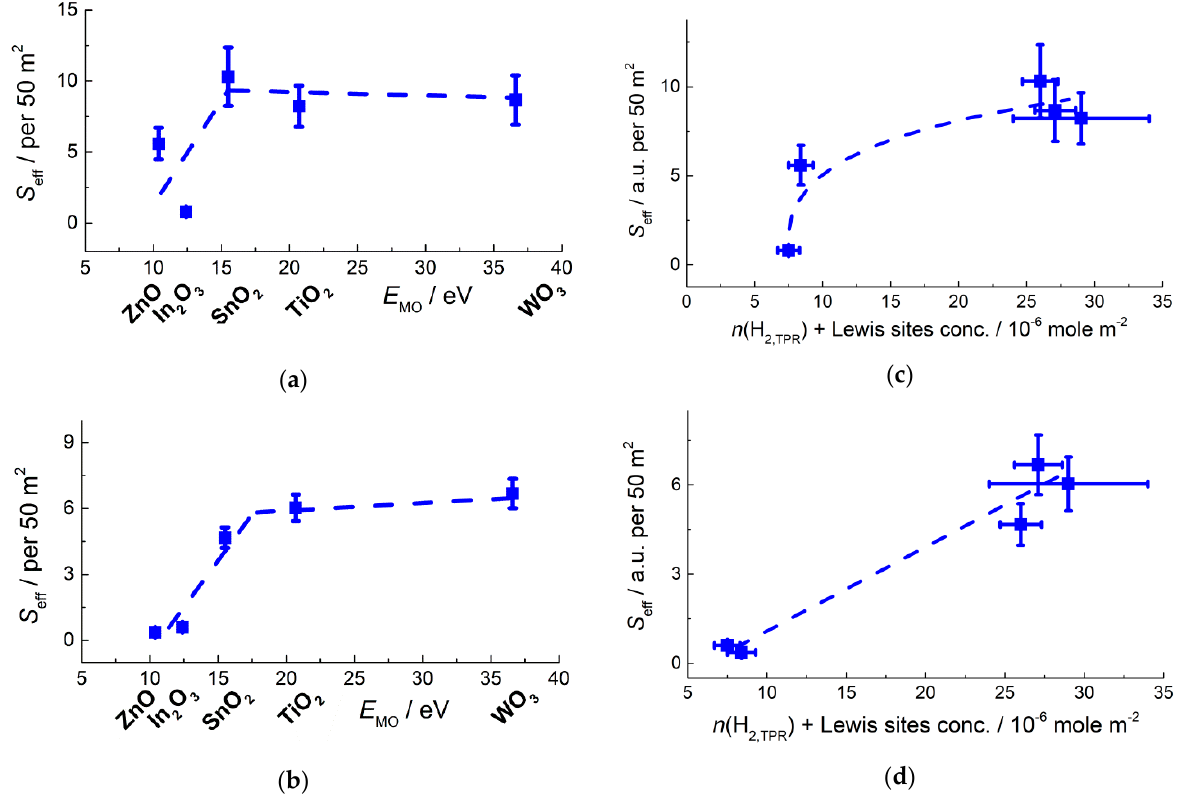
Figure 19. Sensitivity of pristine and Au-functionalized nanocrystalline n -type MOS to 20 ppm acetone ( a , c ) and 20 ppm methanol ( b , d ) at temperature 300 °C in relation to metal-oxygen bond energy in MOS ( a , b ) and sum of Lewis acid sites and oxidizing sites concentration at the MOS surfaces ( c , d ). Adapted with permission from ref. [78]. Copyright 2021 Elsevier.